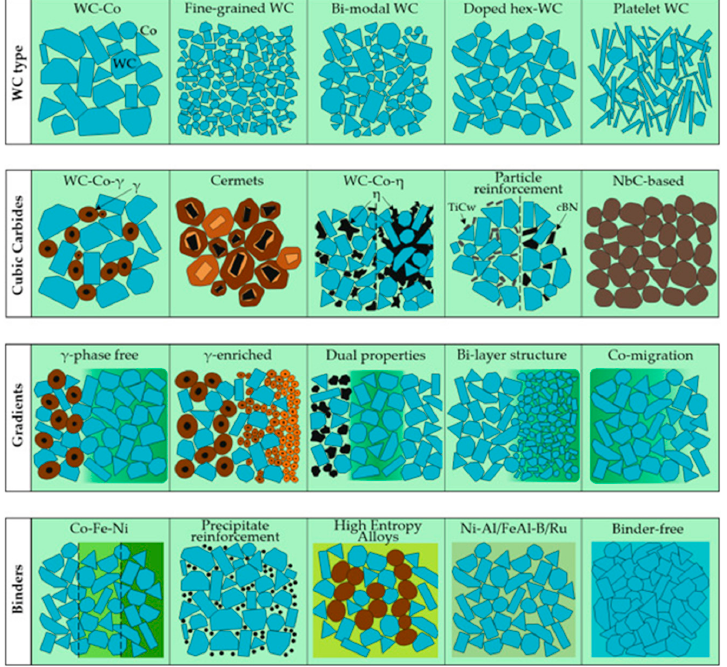
Figure 1. Categorization of cemented carbide microstructures. Reprinted from Ref. [18] with permission from Int. J. Refract. Metals Hard Mater.